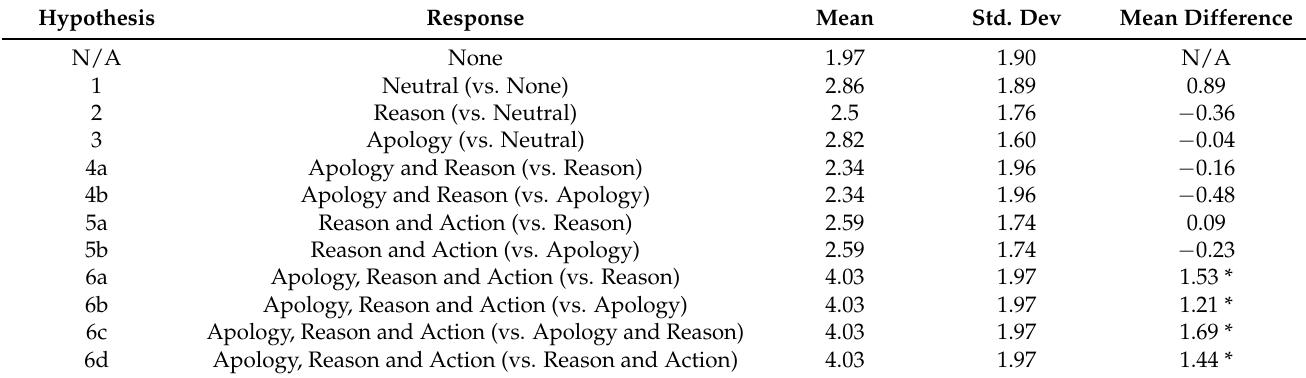
Table 1. Means, Standard Deviation, and Test of